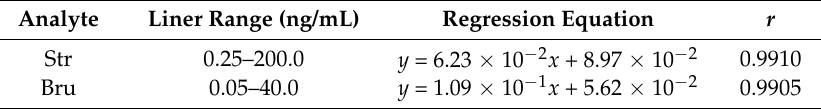
Table 3. Calibration curves for Str and Bru in brain homogenate ( n =